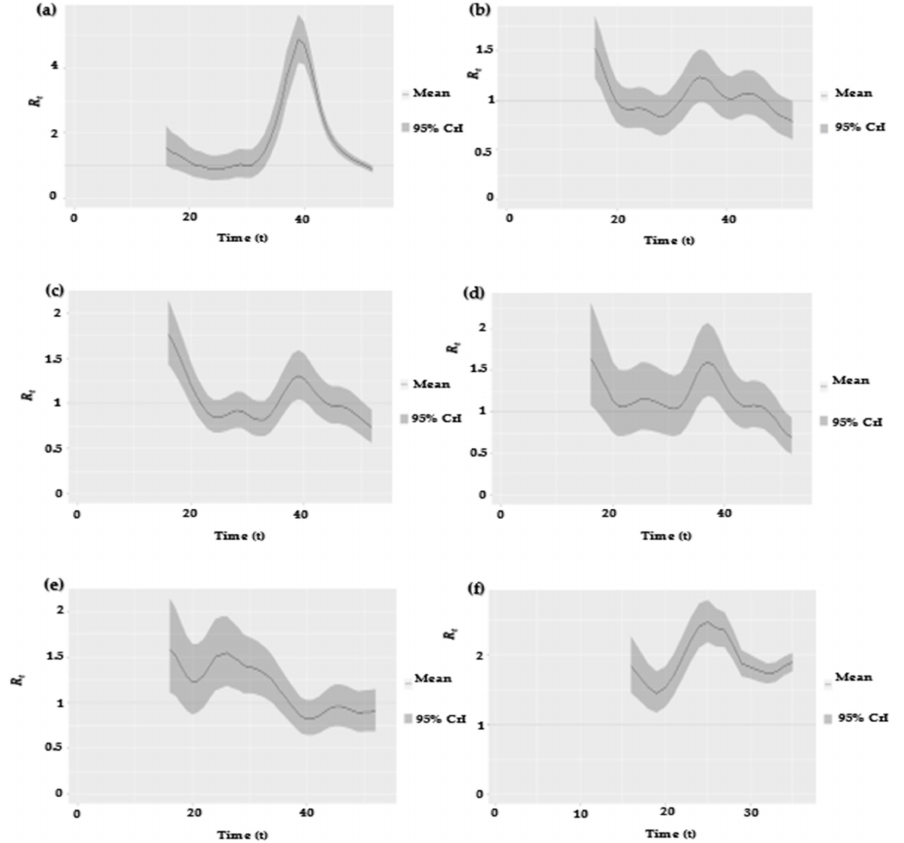
Figure 2. Estimated R eff series for the data from 1 January 2017 to 27 August 2022, represented by panels ( a – f ) using the serial interval from [25]. The solid line denotes the estimated mean, and the shaded gray area represents the 95% credible interval (CrI). The horizontal dashed line marks the level of R eff = 1. Note that R t = R eff